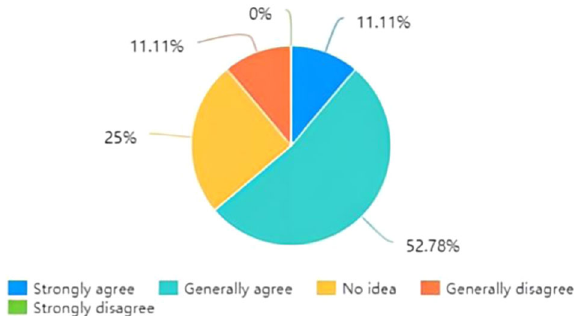
Fig. 2 Preferences for settings for personalised subtitles. This fi gure